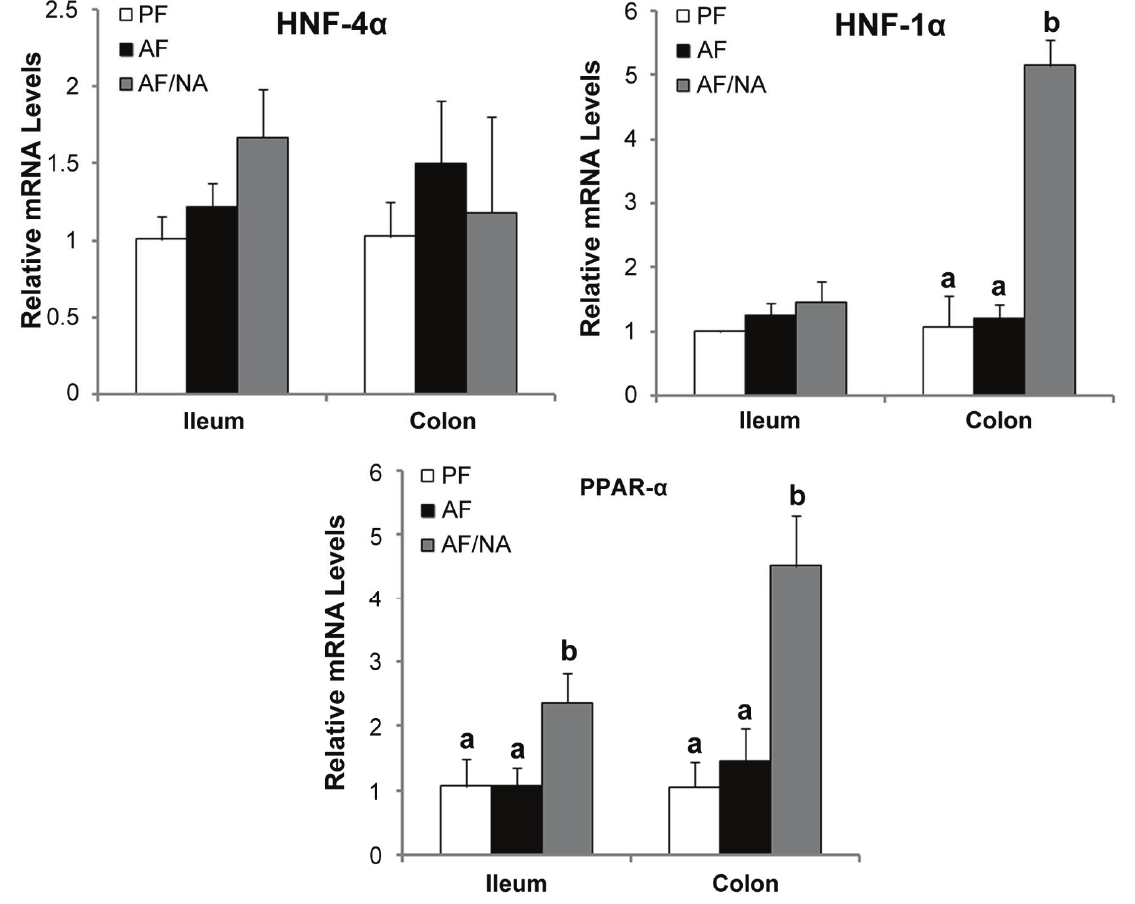
Figure 8. Expression of intestinal epithelial transcription factors in rats fed alcohol with or without nicotinic acid supplementation for 8 weeks. Gene expression was assessed by qPCR assay of mRNA levels. Results are means ± SD ( n = 6–8). Significant differences ( p < 0.05, ANOVA) are identified by different letters. PF: pair-fed; AF: alcohol-fed; AF/NA: alcohol-fed with nicotinic acid